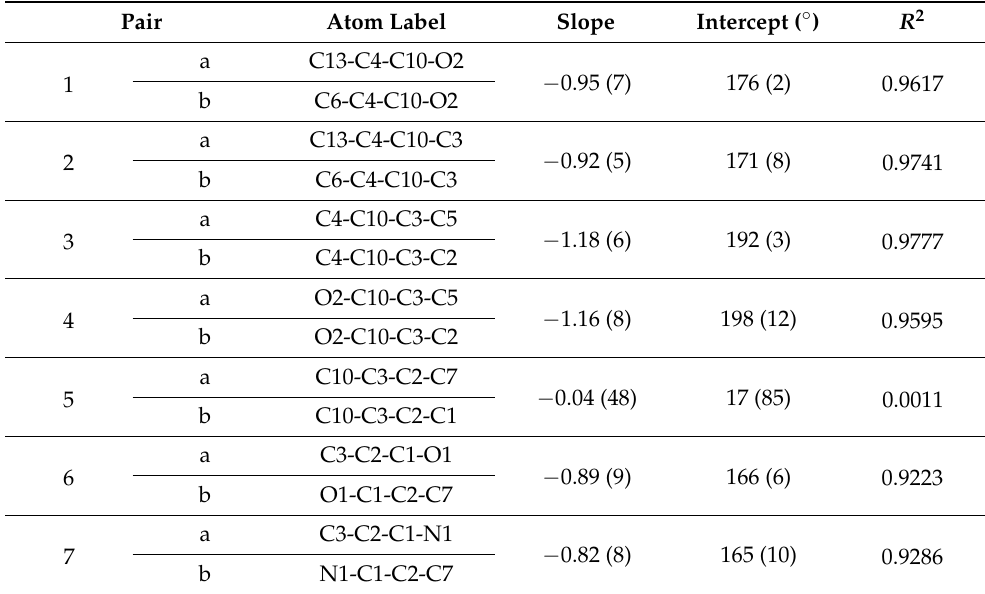
Table 2. Details of the linear relationship between pairs of torsion angles for the core molecule, including the slope and intercept of a linear equation and the coefficient of determination for linear regression ( R 2 ). Pair Atom Label Slope Intercept ( ◦ ) R